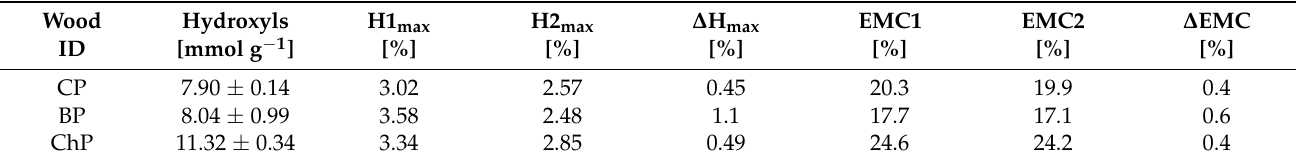
Table 1. Mean values of free hydroxyls, values of maximum hysteresis (maximum difference of EMC between desorption and adsorption) in the first run (H1 max ), maximum hysteresis in the second run (H2 max ), the difference in max hysteresis between the two runs ( Δ H max ), maximum EMC in the first (EMC1) and the second (EMC2) run, respectively, and the difference in maximum EMC between the first and the second run ( Δ EMC) for sound (CP), biologically (B) and chemically degraded (ChP) contemporary pine.